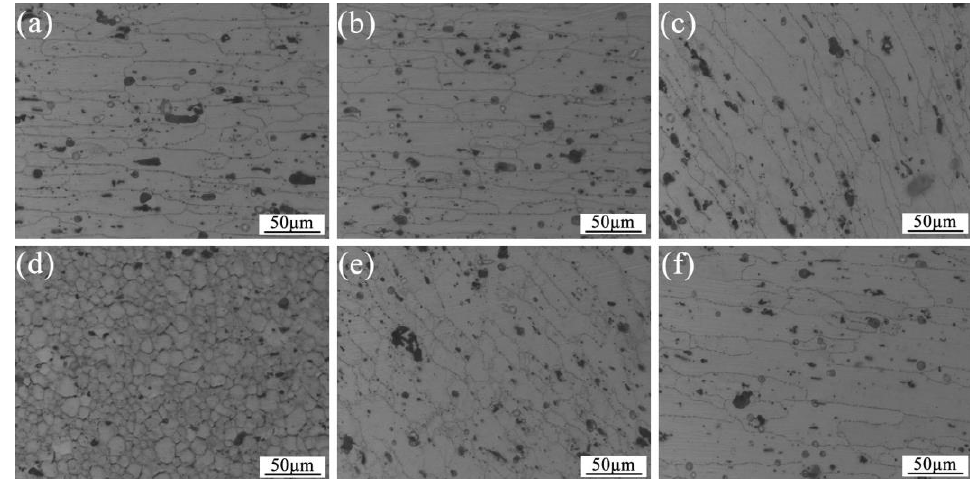
Figure 8. Microstructures viewed with an optical microscope of the joint at 1200 r / min: ( a ) BM, ( b ) HAZ on AS, ( c ) TMAZ on AS, ( d ) SZ, ( e ) TMAZ on RS and ( f ) HAZ on RS.